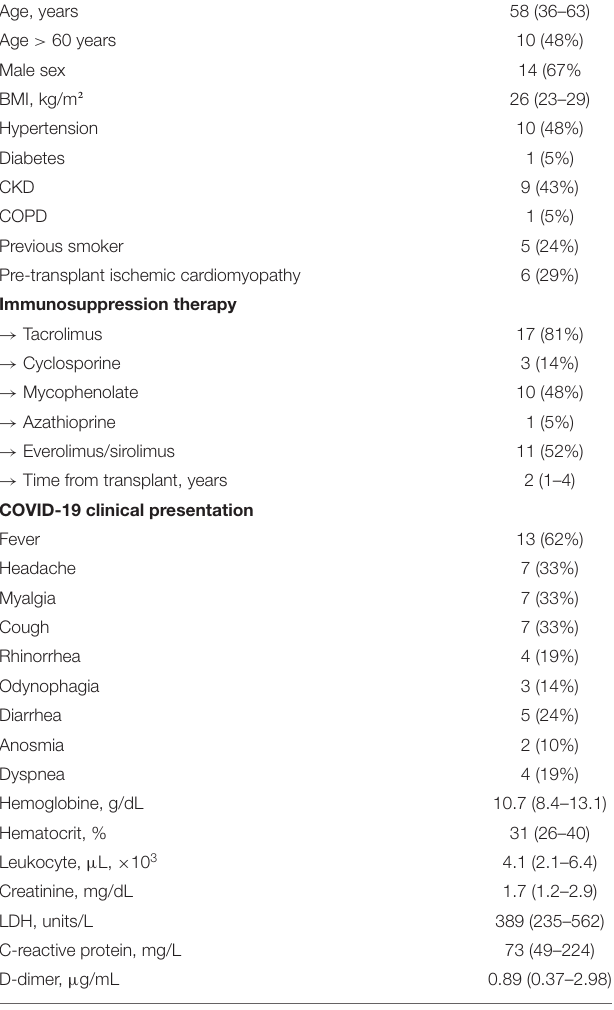
TABLE 1 | Demographics and clinical characteristics at symptoms presentation of heart transplant recipients diagnosed with COVID-19